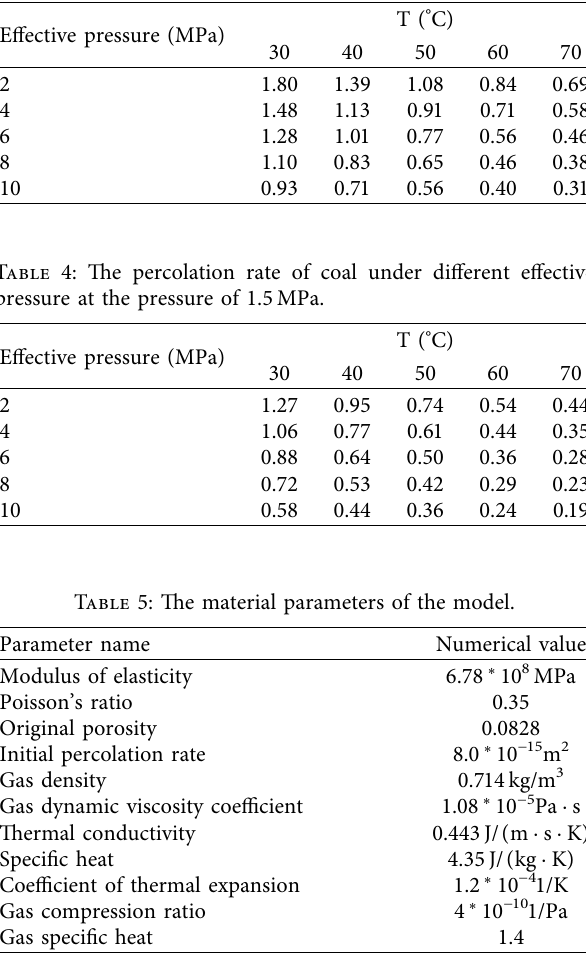
Table 3: The percolation rate of coal under different effective pressure at the pressure of 0.9 MPa.